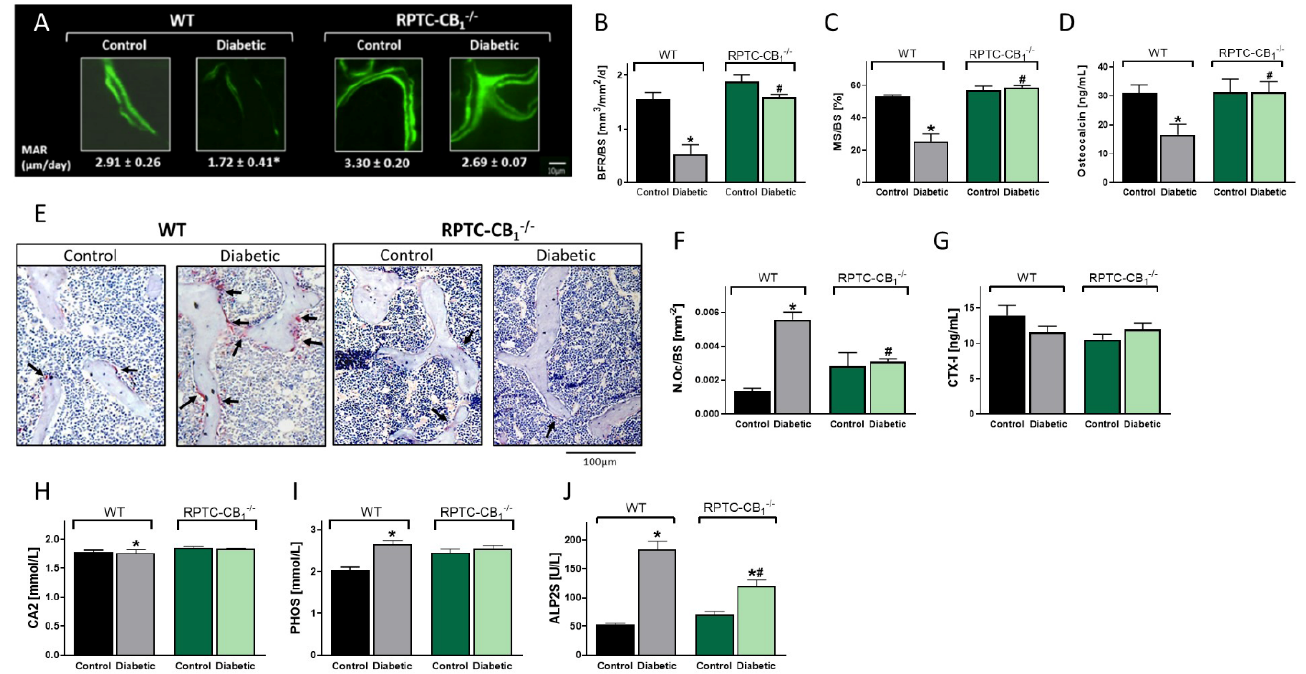
Figure 3. Nullification of CB 1 R in RPTCs prevents diabetes-induced inhibition of bone formation and upregulation in osteoclastogenesis. Representative images of calcein-labeled mineralized fronts with mineral apposition rate (MAR) values ( A ). Bone formation rate (BFR/BS; B ), mineralizing surface (MS/BS; C ), and osteocalcin serum levels ( D ). Images of TRAP+ osteoclasts ( E ), the number of osteoclasts per trabecular surface area (N.Oc/BS; F ), and the serum levels of CTX-1 ( G ). The levels of the circulating biochemical markers, calcium (CA2; H ), phosphate (PHOS; I ), and alkaline phosphatase (ALP2S; J ). Data represent the mean ± SEM from 8–13 animals per group, * p < 0.05 vs. non-diabetic WT control mice, # p < 0.05 vs. diabetic WT mice.